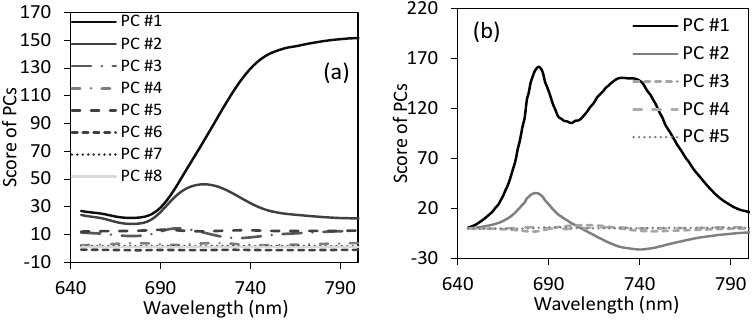
Figure 2. The first eight PCs of the reflectance ( a ) and first five PCs of the SIF ( b ) generated from the 2880 simulated spectra in the training